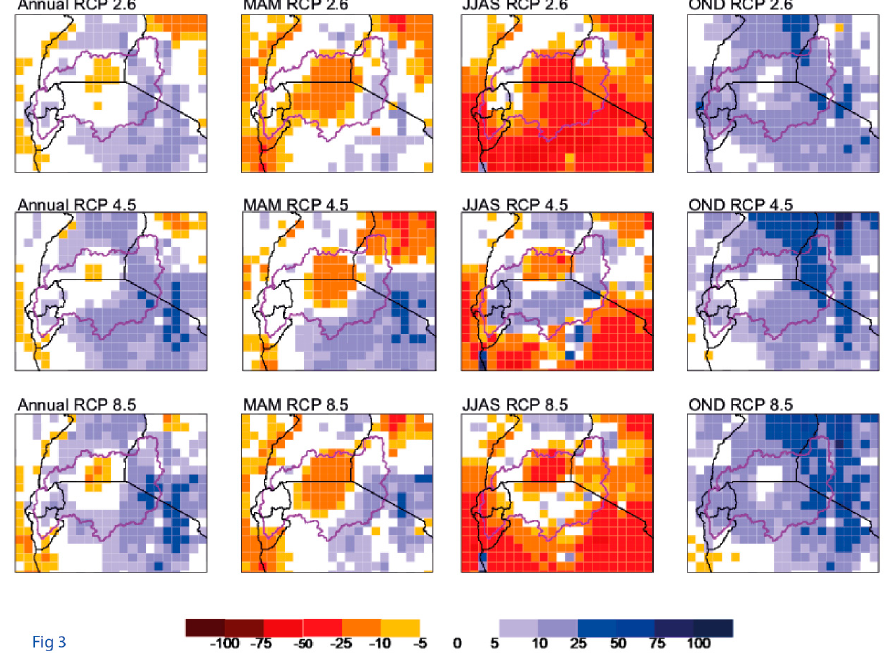
Figure 3. Projected changes in annual, March–April–May (MAM), June–July–August–September (JJAS), and October–November–December (OND) components over the Lake Victoria Basin by the 2050s.